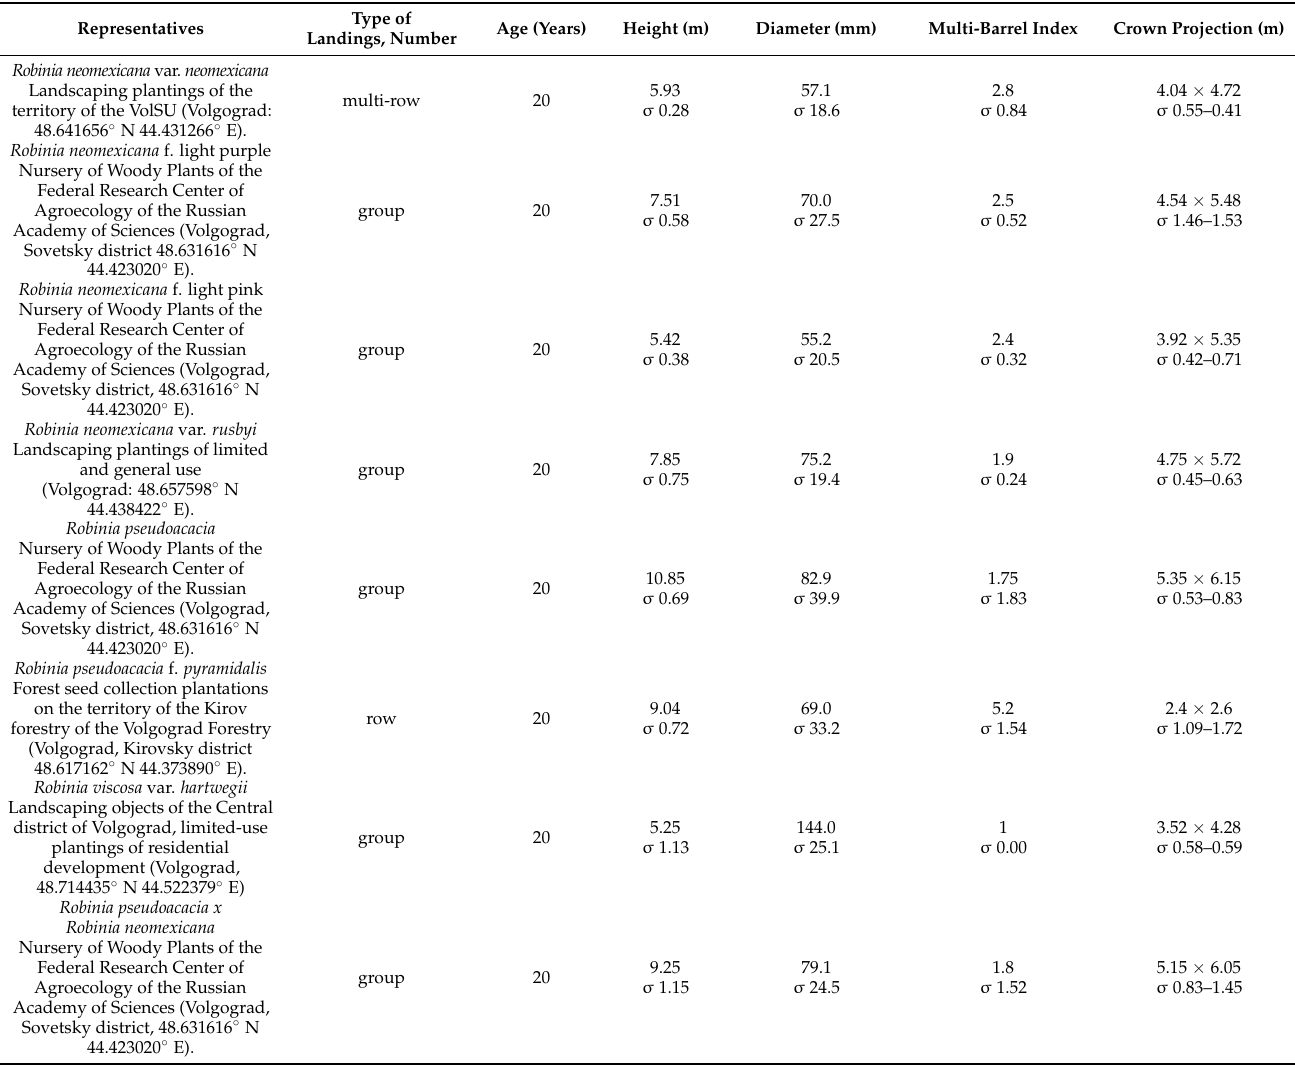
Table 1. The same-age, introduced populations of representatives of the genus Robinia in the land- scaping plantings of the Volgograd